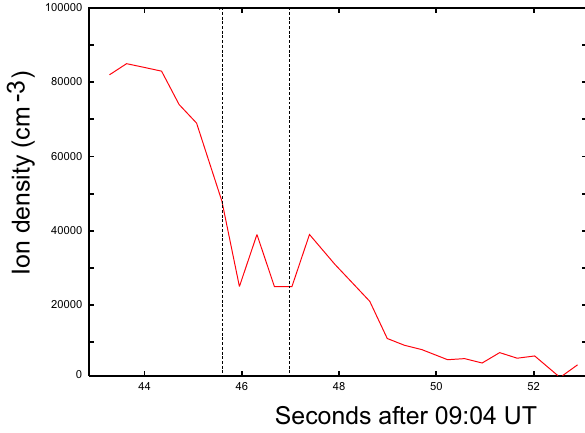
Fig. 3. High time resolution measurements of the ion density per- formed by the RPA as function of time. The dotted lines indicate the locations of the two investigated electromagnetic